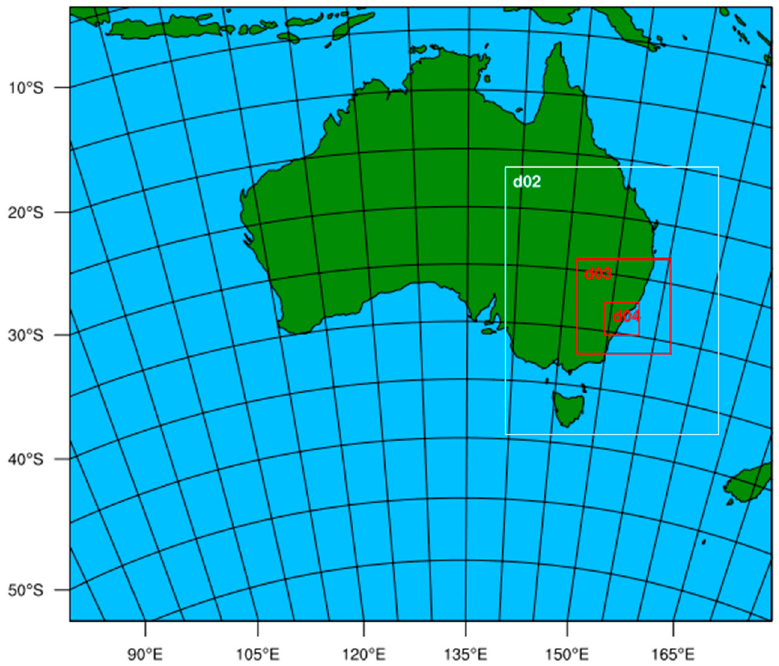
Figure 1. Quadruple-nested modeling domains over Australia at 81-km (d01), southeastern Australia at 27-km (d02), New South Wales at 9-km (d03), and the Greater Sydney at 3-km